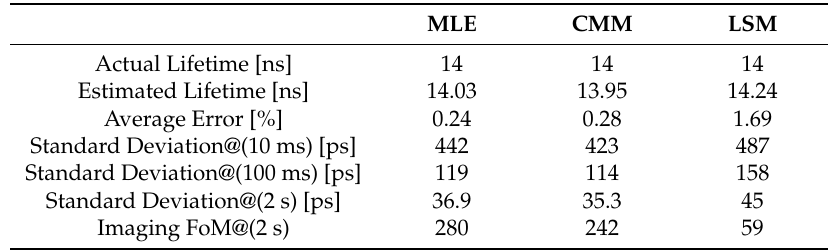
Table 2. The simulation results of lifetimes of 14 ns.